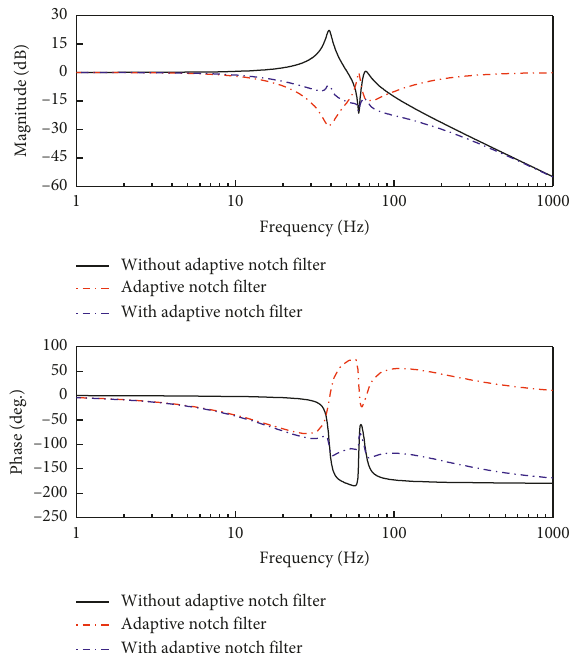
Figure 8: Amplitude-phase characteristic of simulation.